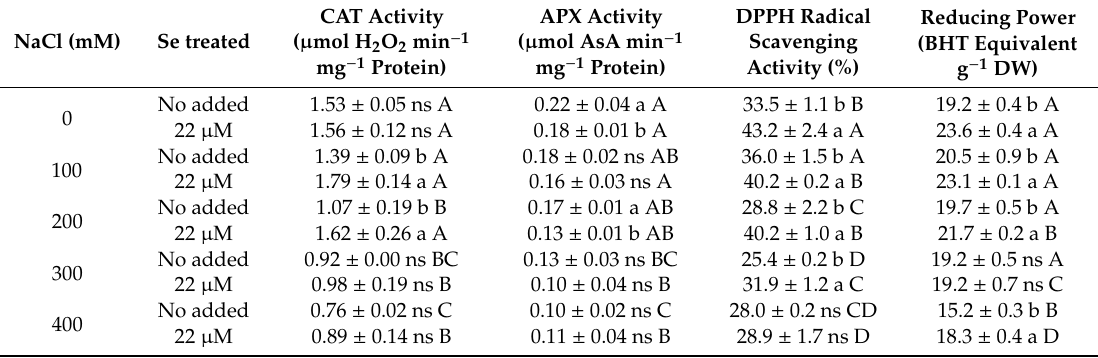
Table 1. Catalase (CAT) and ascorbate peroxidase (APX) activities, DPPH radical-scavenging activity (%), and reducing the power of wheat seedlings.